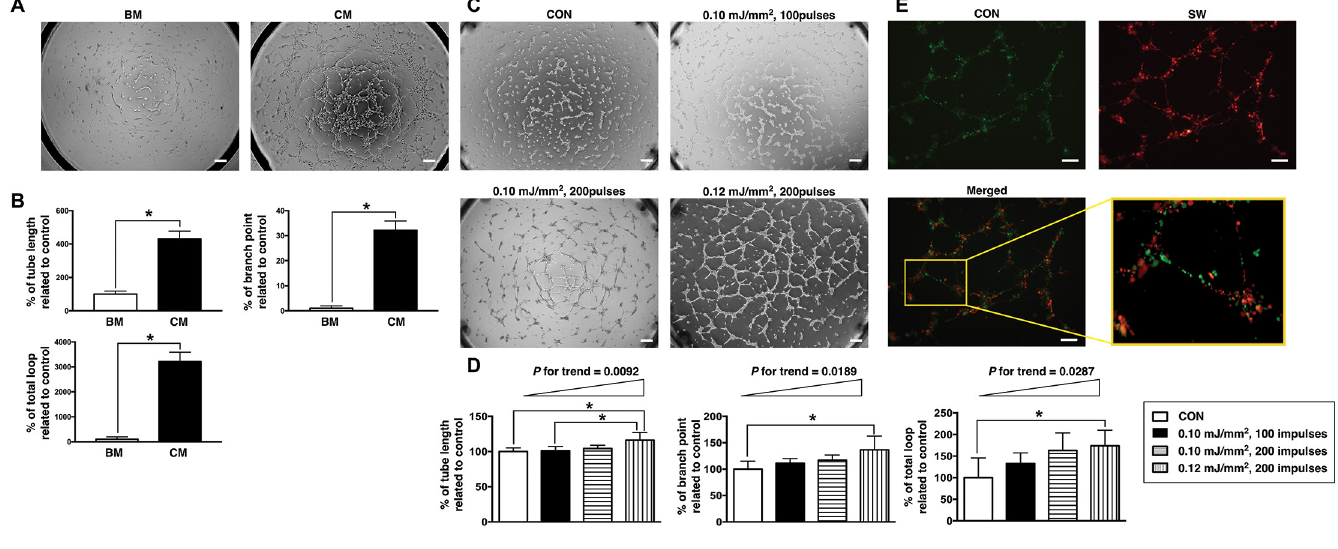
Figure 2. Shock wave (SW)-induced angiogenesis in vitro . (A) Representative images of tube formation assay with basal medium (BM, defined as serum- and growth factors-free) and complete medium (CM). (B) Parameters of tube formation assay, including tube length, branch point and the number of loops (n = 5 in each group). (C) Representative images of tube formation assay in control (CON) group and a dose-dependent increase of SW treatment in HUVECs (scale bar, 200 μ m). (D) Parameters of tube formation assay, including tube length, branch point and the number of loop (n = 5 in each group). P for trend in those parameters showing a dose-dependent increased order. (E) Control (CON) and SW-treated HUVECs labeled with PKH67 (green) and PKH26 (red), respectively. Representative images of fluorescence signals (scale bar, 100 μ m). Merged image with magnification indicated by yellow line showing amalgamation in tube formation assay. Data shown as mean ± S.D. * P < 0.05 determined by Student t